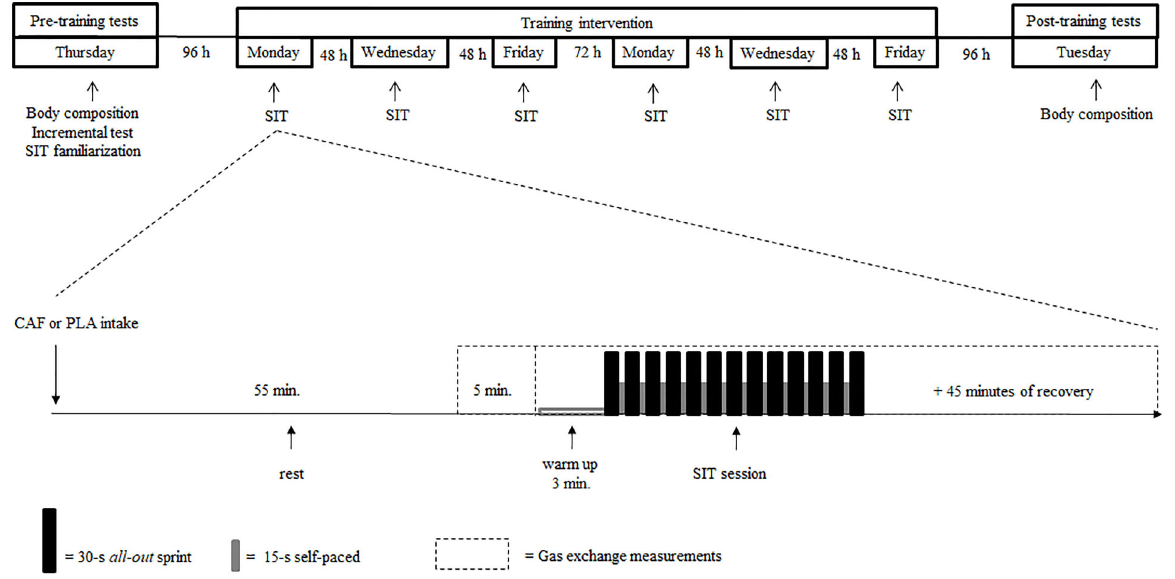
Figure 1. Experimental design of the study. SIT: Sprint interval training; CAF: caffeine; PLA: